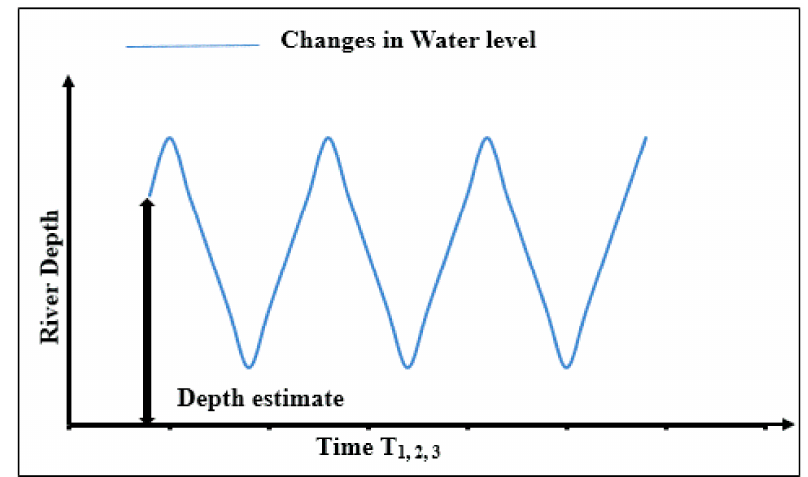
Figure 6. Adjustment of the estimated river depth at time (T) to capture the changes in the water level at times (T 1, 2, 3, … n ). The blue line shows an estimate of peak river depth by using Equation (12) at time tpeak. The time-series black lines illustrate the water level from the Envisat satellite altimetry data. Through comparing the river depth values at tpeak, the altimetry data can be adjusted accordingly. (7)